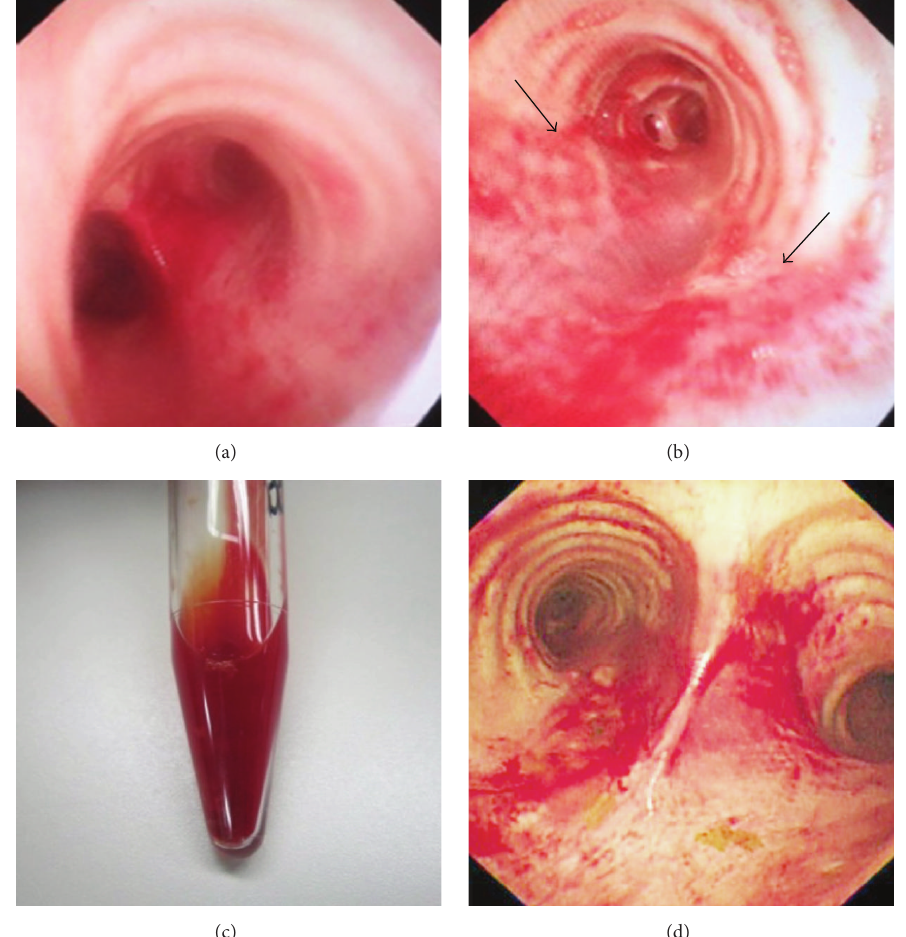
Figure 3: Flexible bronchoscopy on the day of admission revealed fresh blood in the entire tracheobronchial tree (a), and a copious frothy blood-tinged secretion was suctioned form the throat (b, c). Tracheobronchial tree on hospital day 1